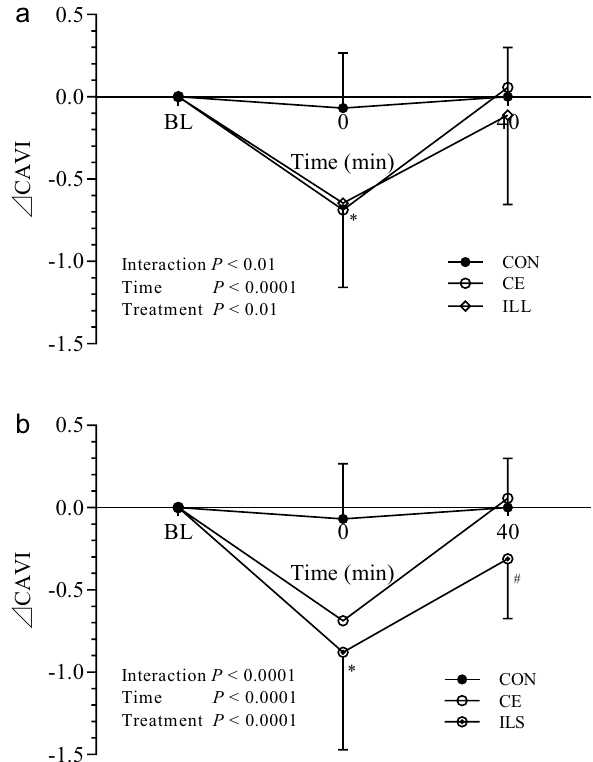
Figure 2. Time course of arterial stiffness response to exercise with and without interval of different duration. Mean (± SD) time-dependent ⊿ CAVI changes in CON, CE and ILL trials ( a ) and CON, CE and ILS trials ( b ). Statistical analysis was performed using two-factor (treatment and time) repeated measures ANOVA with Bonferroni post-tests. Data are means ± SD, n = 20. * P < 0.0001, CE, ILL, ILS and ISS vs. CON at 0 min. # P < 0.05, ILS vs. CON and CE at 40 min. CAVI Cardio-ankle vascular index, BL baseline, CON control, CE continuous exercise, ILL intermittent exercise of long bouts with long interval, ILS intermittent exercise of long bouts with short interval, ISS intermittent exercise of short bouts with short